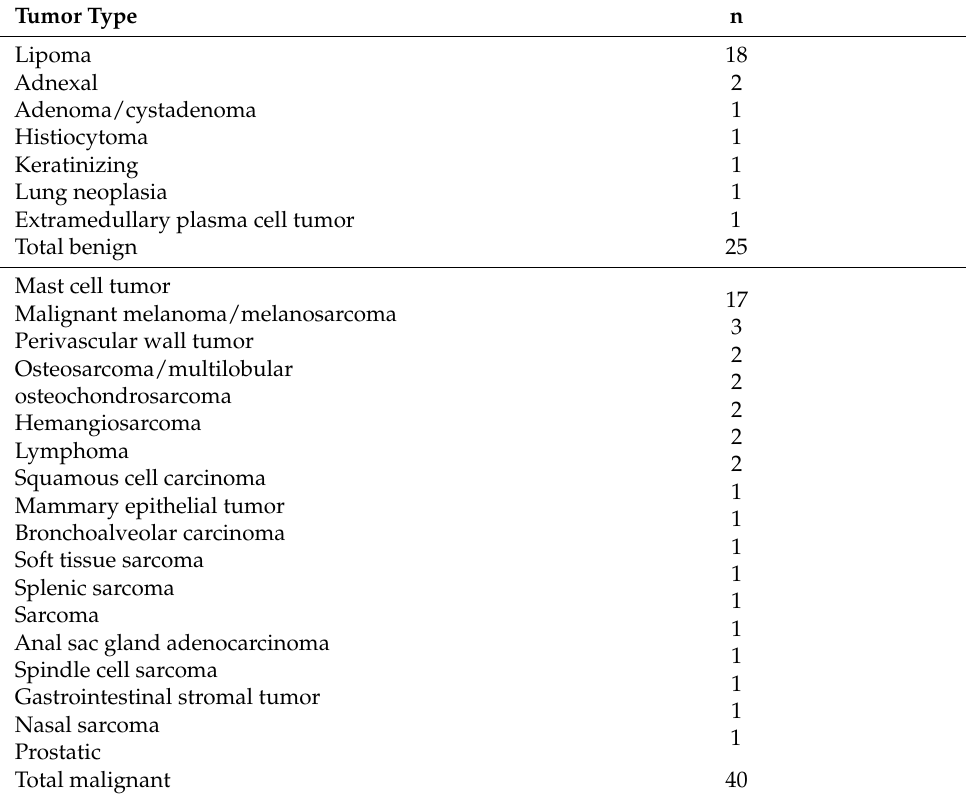
Table 2. Study population by tumor type.